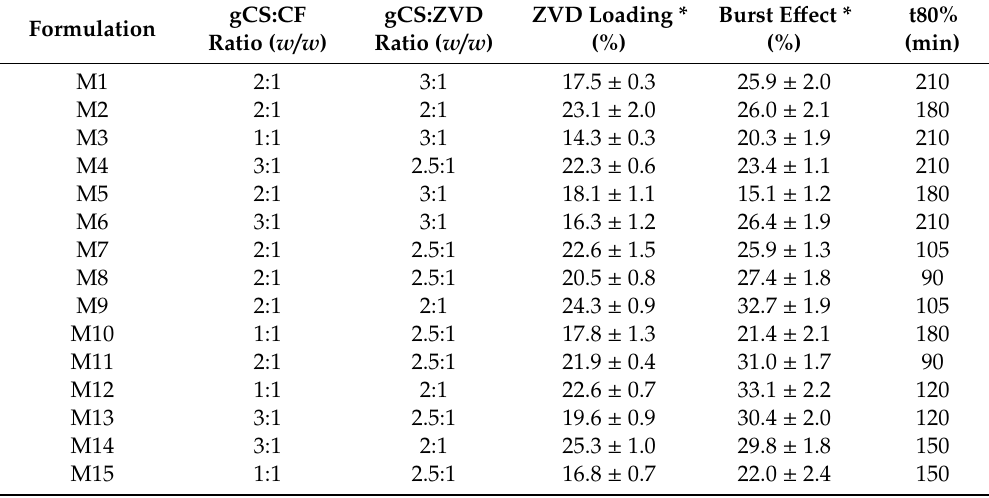
Table 2. Drug loading and results from dissolution studies expressed as the percentage of drug released within the first 30 min (burst e ff ect) and the time required for 80% of the drug dissolved in the acceptor medium (t80%) ( n =